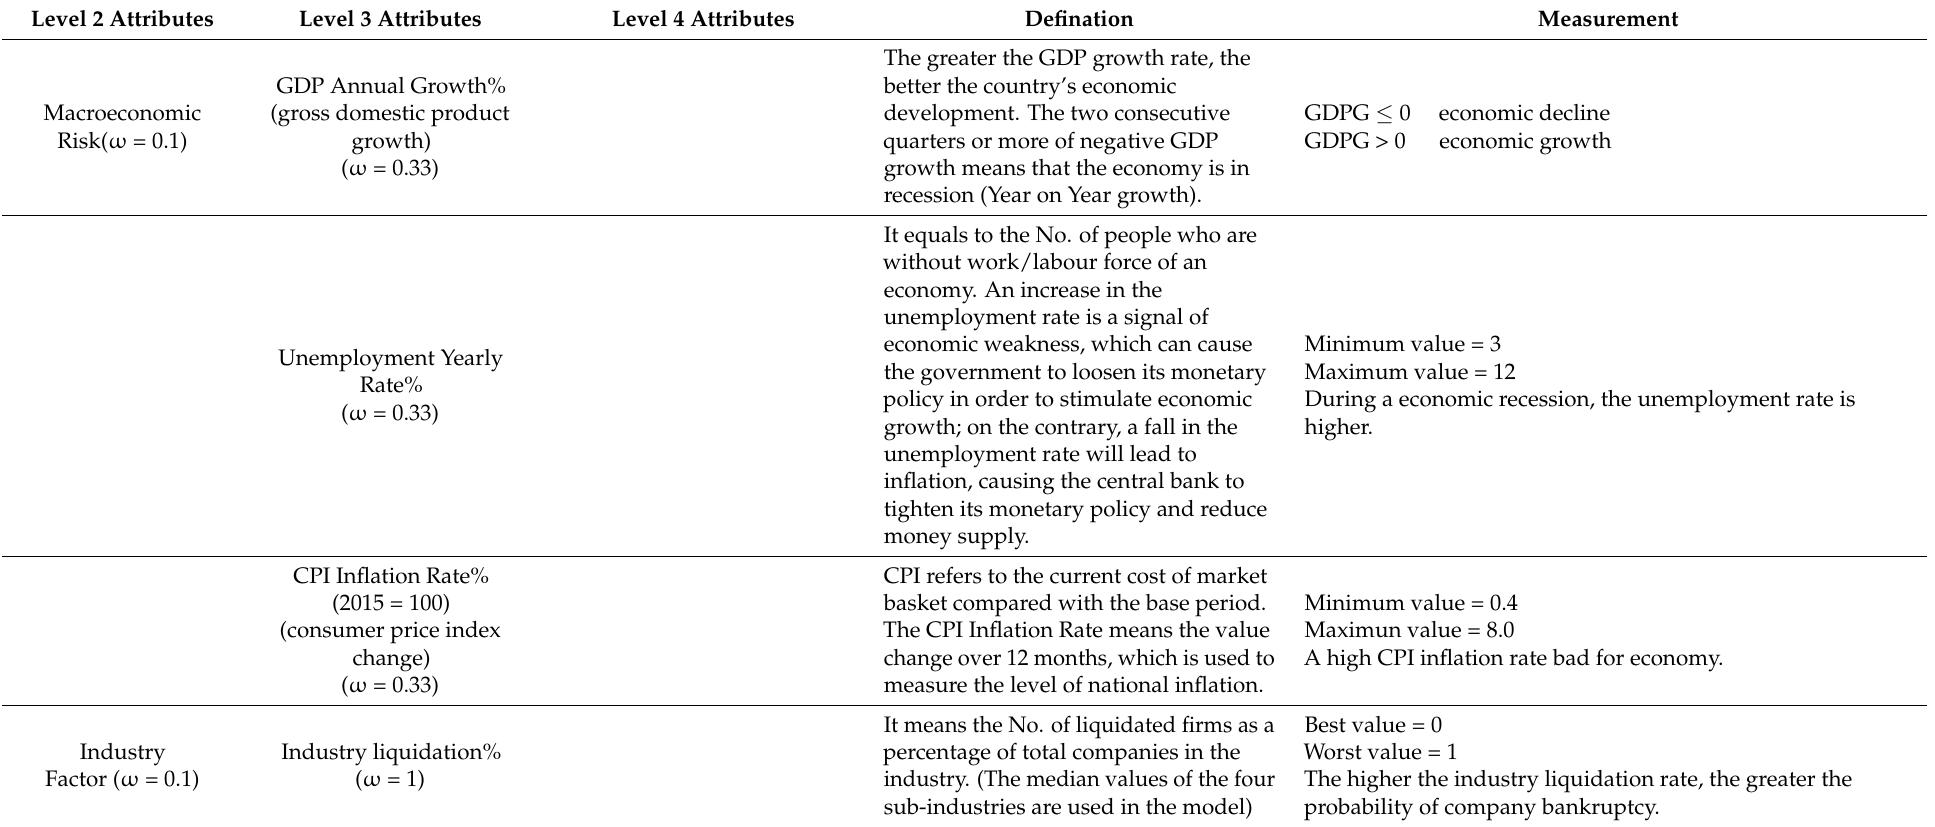
Table A1. Descriptions and measurements for all